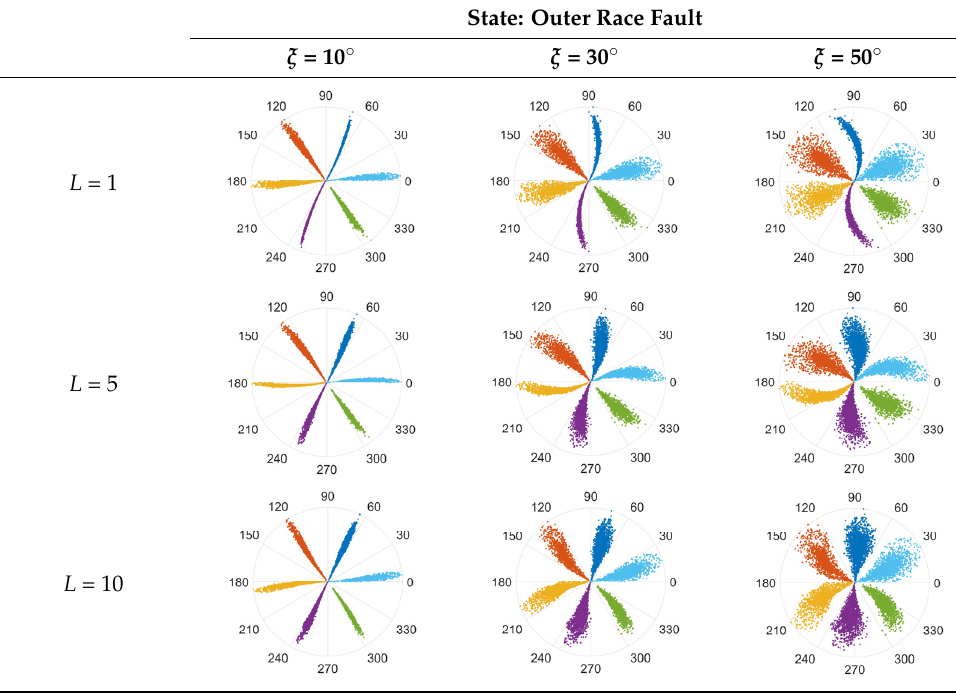
Figure 9. Testbed of CWRU.